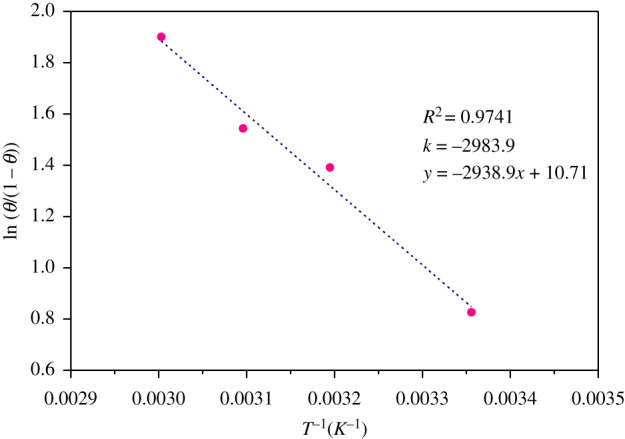
ln(θ/(1 − θ))∼1/T plots in the presence of 10 mM PPAPO and 3 mM Na2WO4.